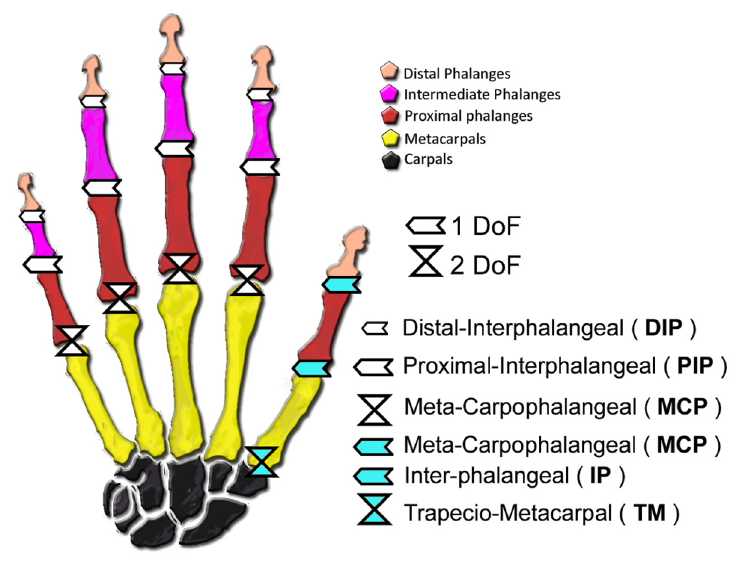
Figure 1. Human hand model.